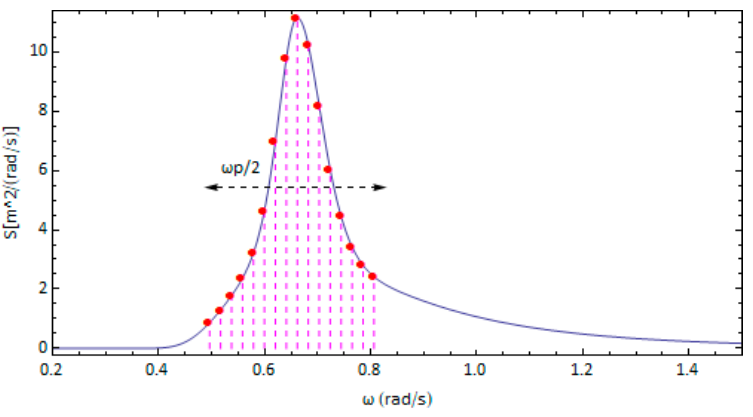
Figure 3. The JONSWAP spectrum with the frequency range and frequencies considered. J. Mar. Sci. Eng. 2020 , 8 , x FOR PEER REVIEW